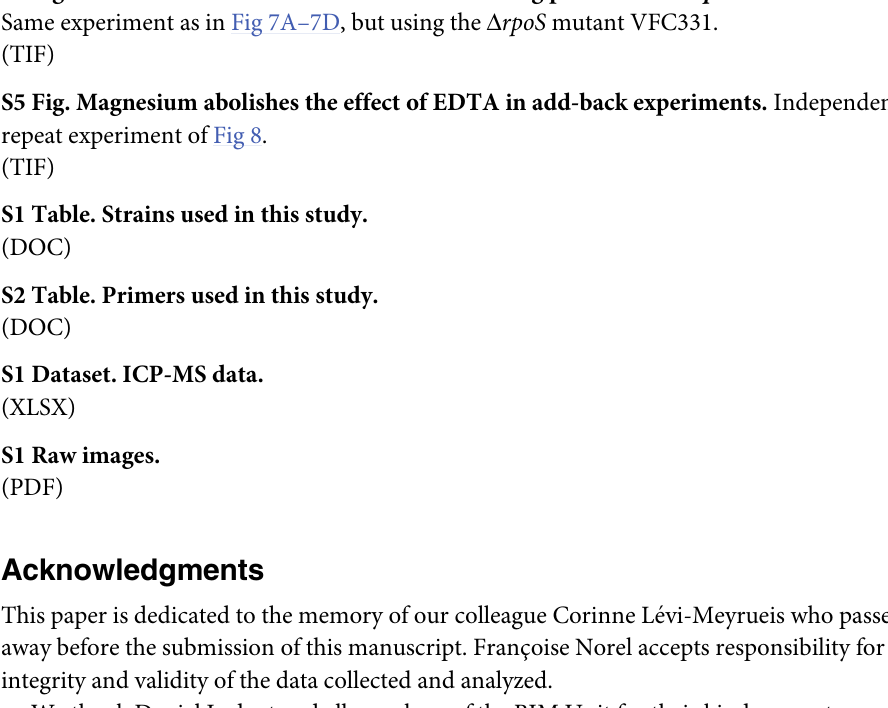
expression of SPI2 Type 3 secretion system”. S3 Fig. The metal ion chelator EDTA extends the lag phase of the Δ rpoS mutant. Biological replicates of that in Fig 7. S4 Fig. The metal ion chelator EDTA extends the lag phase of the Δ rpoS mutant VFC331. Same experiment as in Fig 7A–7D, but using the Δ rpoS mutant VFC331. S5 Fig. Magnesium abolishes the effect of EDTA in add-back experiments. Independent repeat experiment of Fig 8. S1 Table. Strains used in this study. S2 Table. Primers used in this